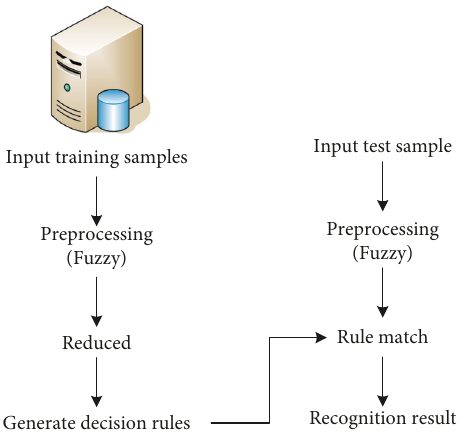
Figure 1: A recognition framework based on fuzzy rough black. If the attributes of squares and circles are intro- duced, the objects can be further divided into four cat- egories: black square objects, black round objects, white square objects, and white round objects. At this time, if the two objects are both black, they are still indistinguishable.